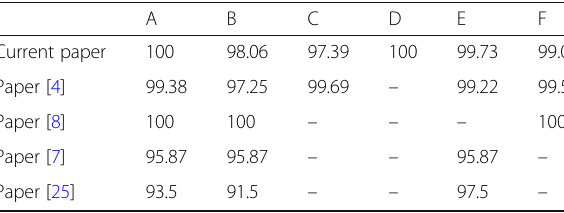
Table 6 Comparison of the accuracy of several methods